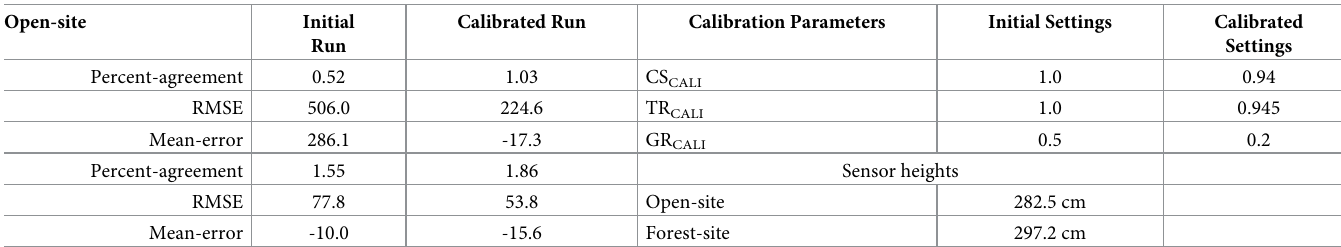
Table 3. Moose Mountain parameters, initial results, and calibrated results.